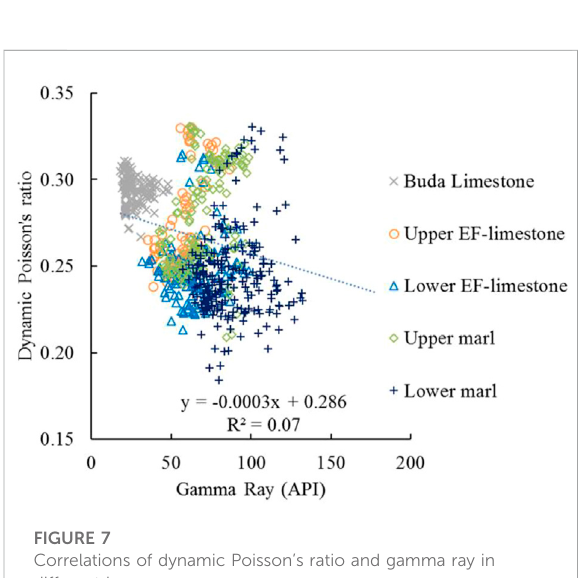
FIGURE 7 Correlations of dynamic Poisson ’ s ratio and gamma ray in different layers.